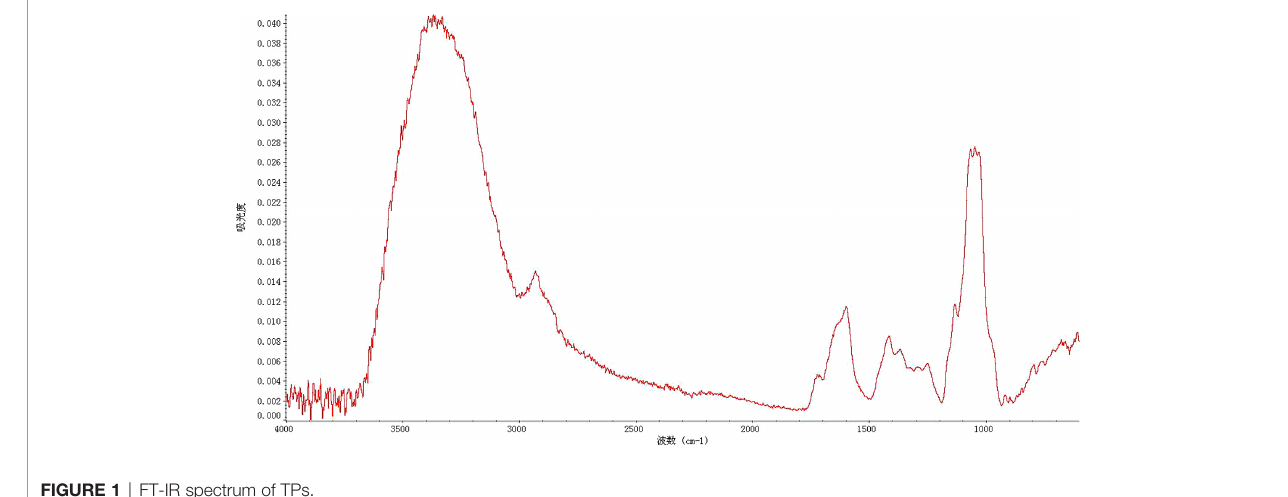
FIGURE 1 | FT-IR spectrum of TPs.